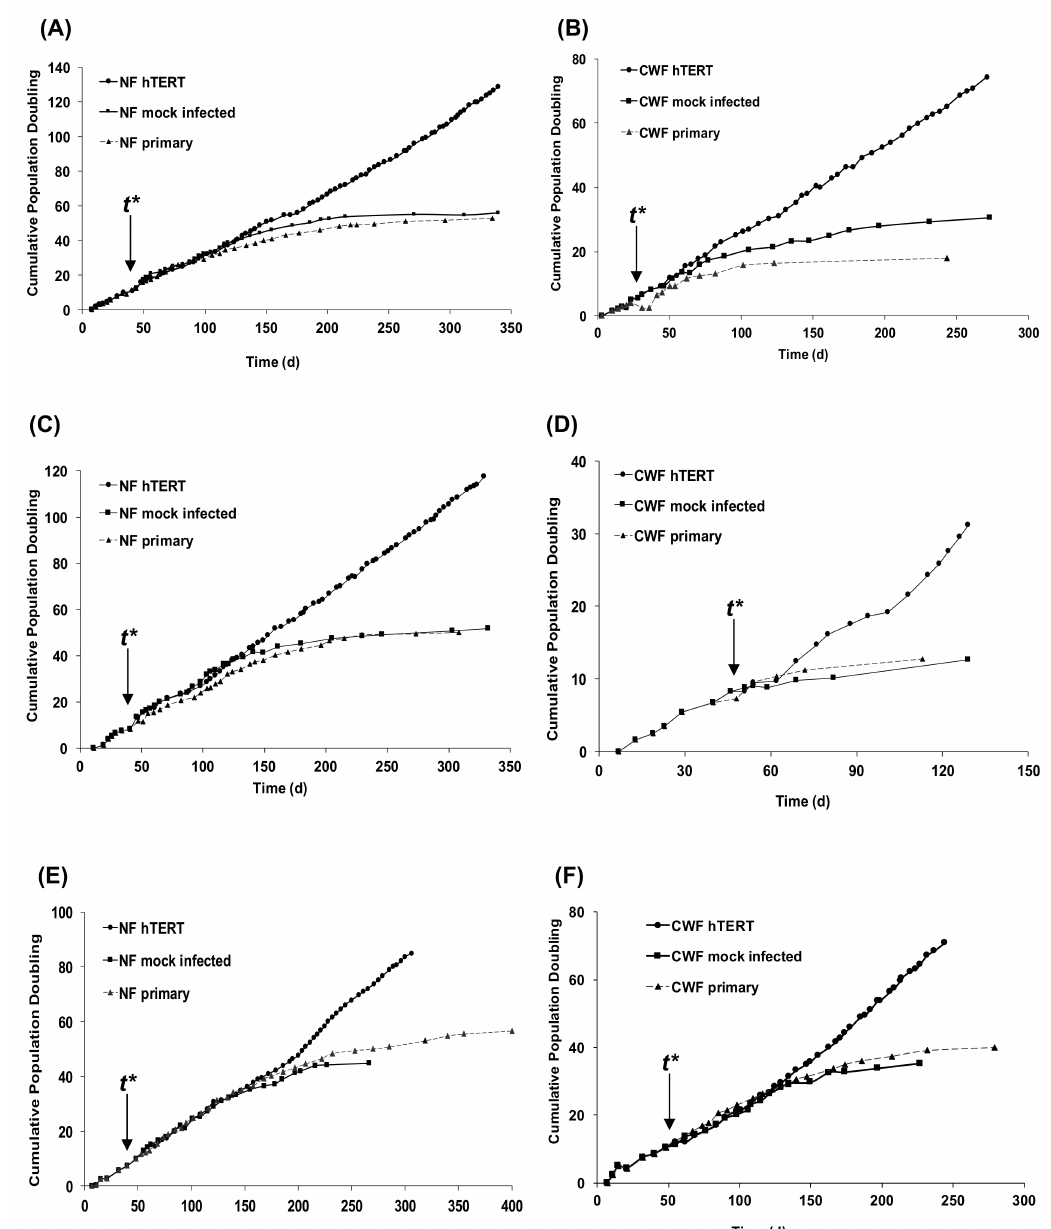
Figure 1. Cumulative population doublings for normal skin (NF) ( A , C , E ) and chronic wound fibroblasts (CWF) ( B , D , F ) primary cells ( (cid:78) ), mock-infected cells ( (cid:4) ) and catalytic component (hTERT)-infected cells ( ) from Patient 1 ( A , B ), Patient 2 ( C , D ) and Patient 3 ( E , F ). hTERT-immortalized cell lines were established for both CWF and NF by infecting cells at time t * (indicated in Figure 1) with a retrovirus carrying the gene encoding hTERT along with the puromycin resistance gene for the selection of the cells ectopically expressing active telomerase. To control for the infection procedure, “mock infected” cells were prepared by infecting cells with an empty vector (containing the puromycin resistance gene) only. For all of the patients examined a notable extension of lifespan was achieved for all populations of CWF-hTERT and NF-hTERT. None of